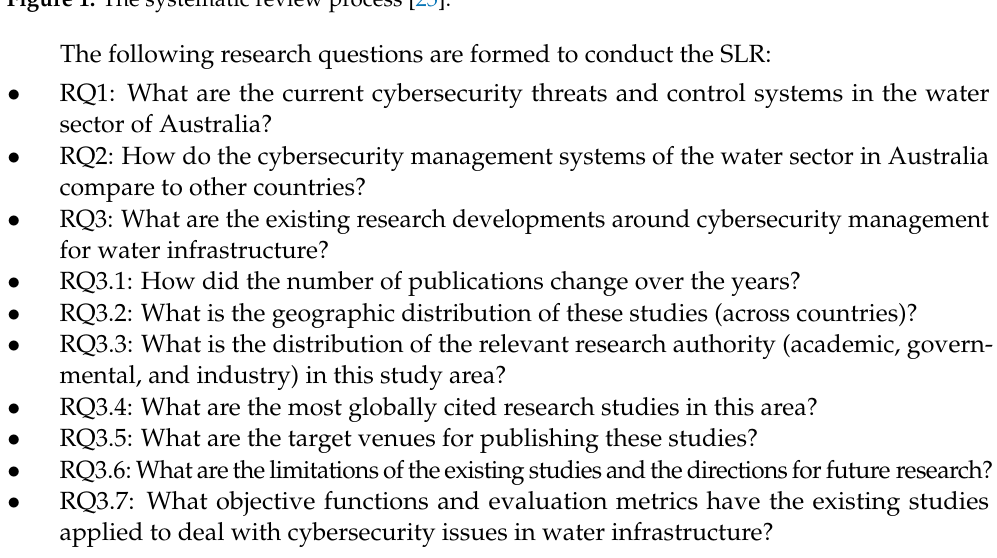
Figure 1. The systematic review process [25].